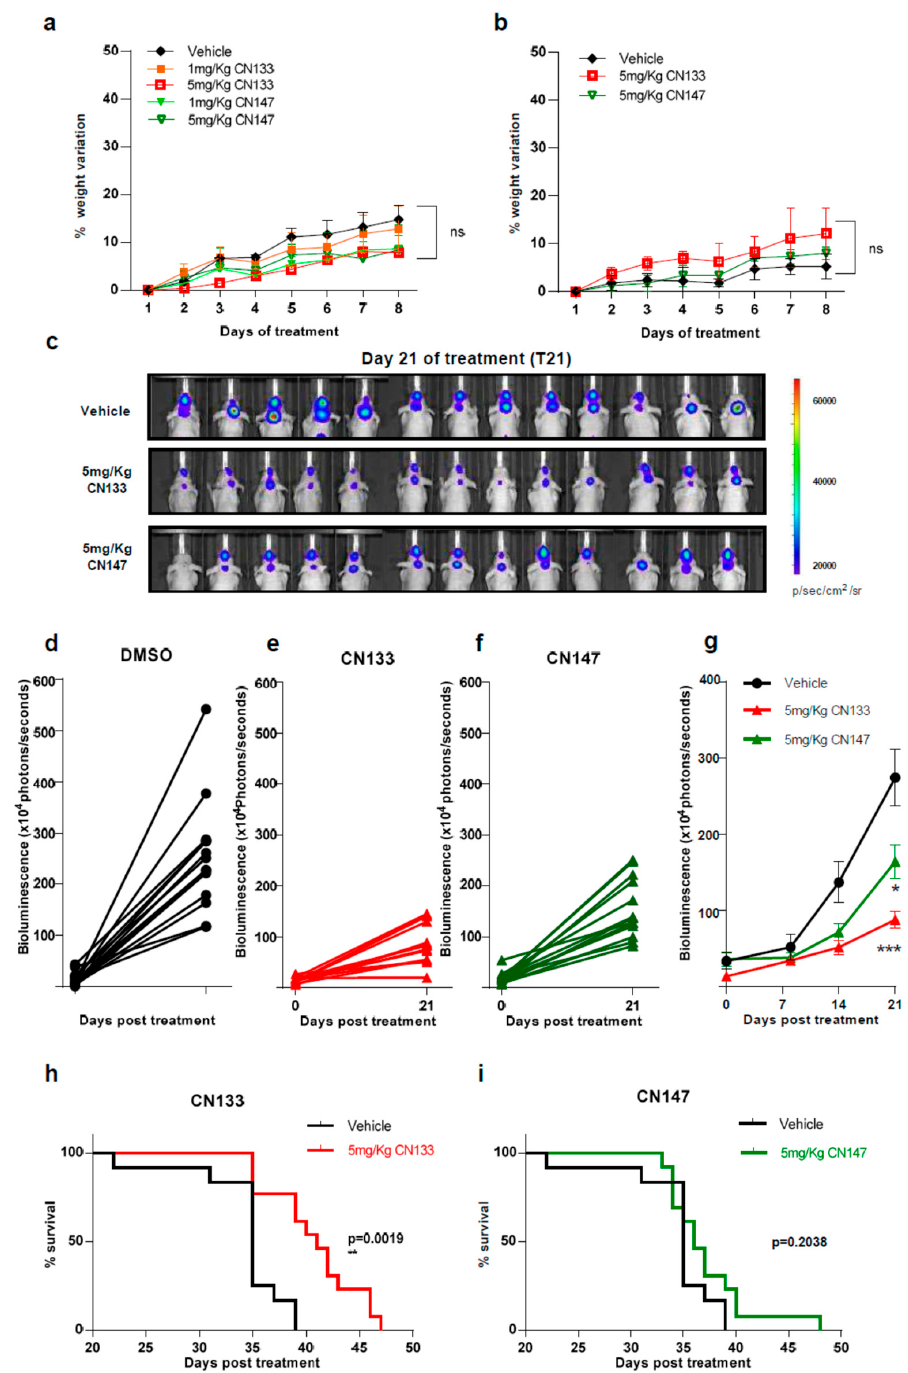
Figure 4. CN133 delays EPN tumors growth and extends survival of mice bearing EPN orthotopic xenografts. Percentage of weight variation of nude mice treated with 1 or 5 mg / kg of CN133 or CN147 for 8 days by i.p. administration ( n = 5 mice / group) once ( a ) or twice a day ( b ); ( c ) representative bioluminescent images at the indicated days of EPP luciferase-transduced cells orthotopically-injected in the posterior fossa of nude mice; ( d–f ) bioluminescence quantification of EPP tumors progression at 21 days post treatment DMSO ( d ) C133 ( e ) and C147 ( f ); ( g ) bioluminescence quantification of EPP tumors over time ( h , i ) Kaplan–Meier survival curves of mice implanted with EPP luciferase-transduced cells ( n = 13 / group) and treated with vehicle or the indicated drugs.